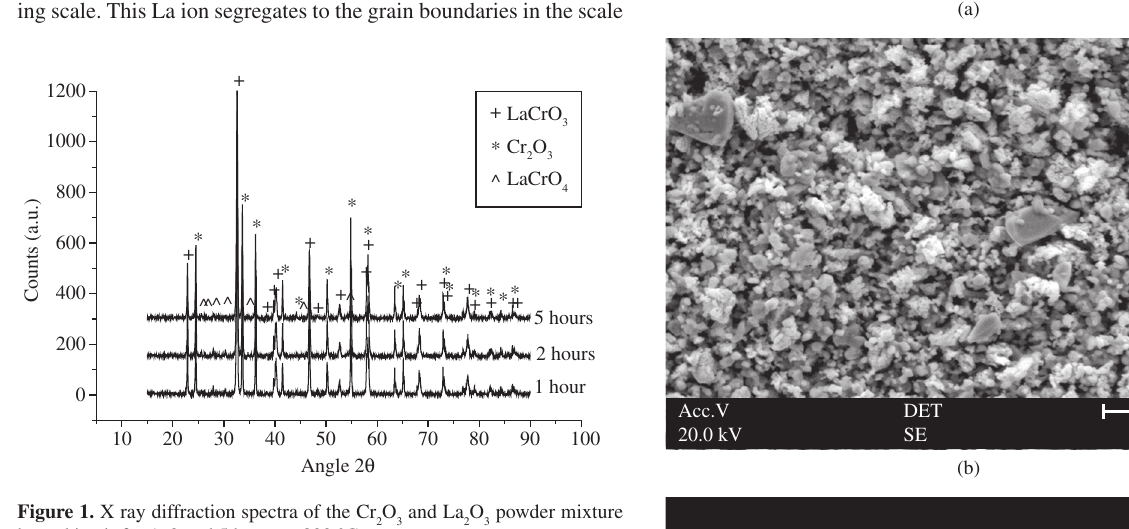
Figure 1. X ray diffraction spectra of the Cr heated in air for 1, 2 and 5 hours at 800 °C.